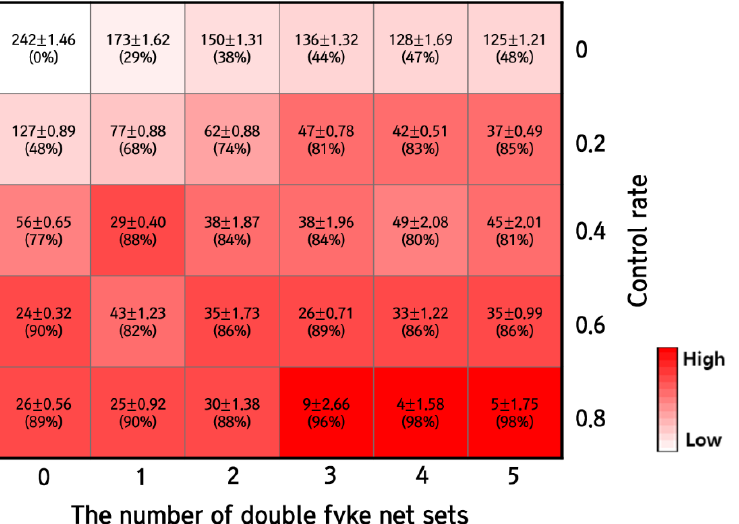
Figure 7. The number of the remaining adult population (mean ± SE) and reduction rate of L. catesbei- anus after combining the two control methods. L. catesbeianus after combining the two control